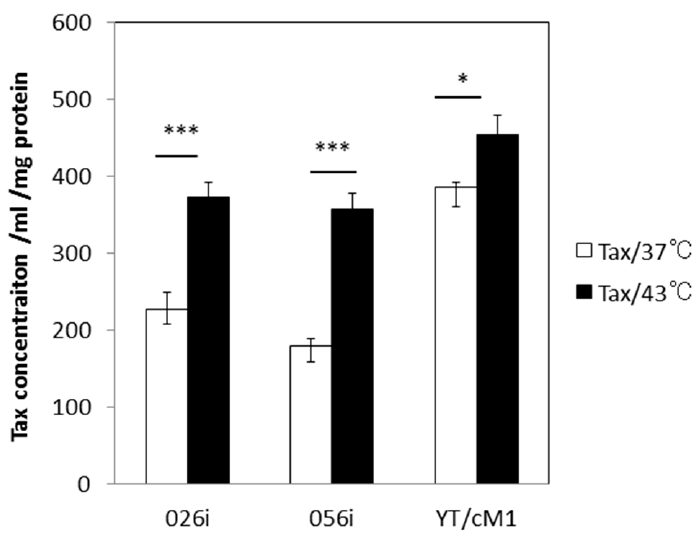
Figure 2. Effect of HS on total Tax protein expression: Aliquots of the ATL ‐ derived cell lines (ATL ‐ 026i and ATL ‐ 056i) and the HTLV ‐ I ‐ immortalized CD4 + T cell line (YT/cM1) were incubated at either 37 °C or 43 °C for 30 min followed by incubation for 24 h in triplicates wells. The cells were then collected, washed, lysed in lysis buffer and the total protein concentrations were determined. Then amounts of total Tax concentration/mg total protein were quantitated using our Tax specific enzyme ‐ linked immunosorbent assay ELISA. The values denote the means ± SD. * p <0.05, *** p <0.001.